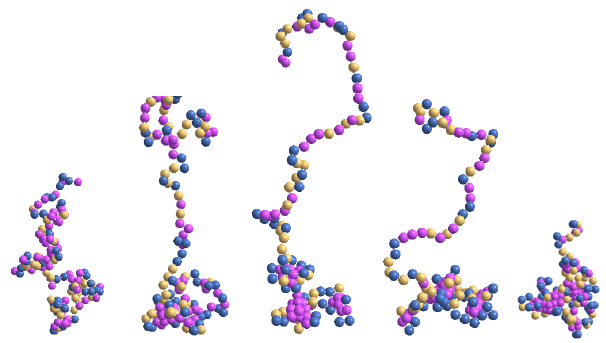
Figure 1. Snap shots of the protein at the end of 10 7 time steps at temperature T=0.020 for the solvent interaction strength f s =1,5,14,16 , and 20 (from left to right) on a 64 3 lattice. Colors pink (hydrophobic residues), golden (polar), and blue (electrostatic) represent residues in different groups without distinction within.